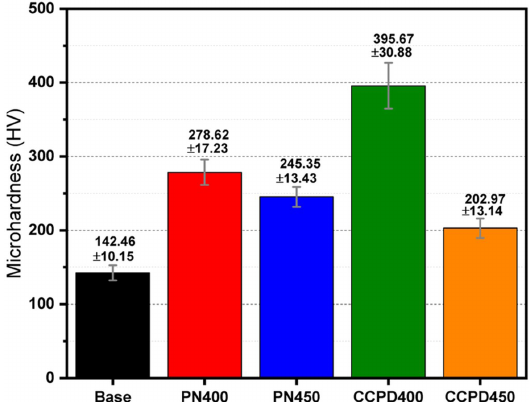
Figure 4. Microhardness values of treated and untreated niobium samples.